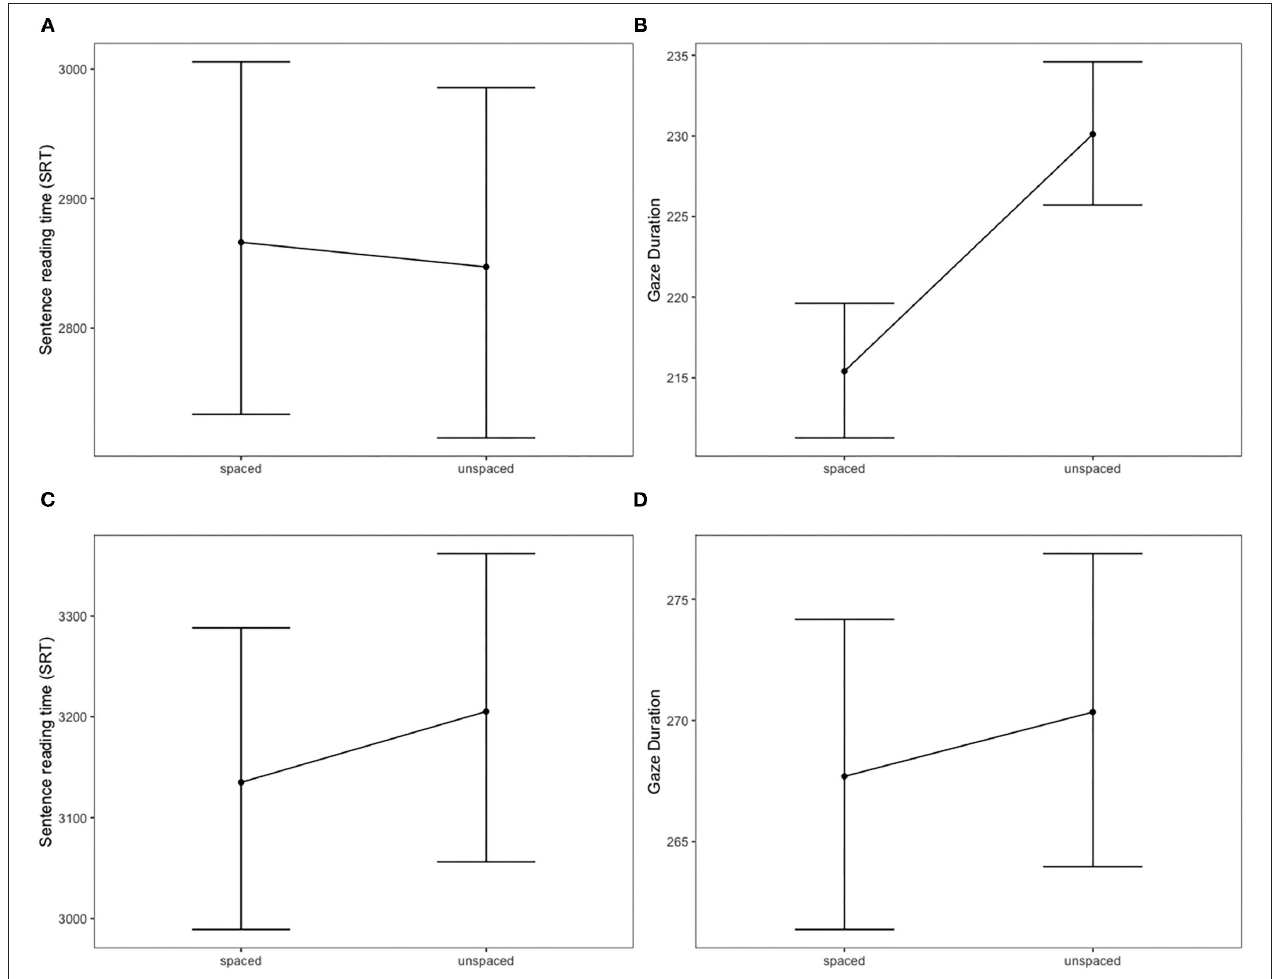
FIGURE 1 | Top left (A) Partial effects of spacing (heavily spaced vs. unspaced) on sentence reading times, Experiment 1. Top right (B) Partial effects of spacing (heavily spaced vs. unspaced) on gaze duration, Experiment 1. Bottom left (C) Partial effects of spacing (lightly spaced vs. unspaced) on sentence reading times, Experiment 2. Bottom right (D) Partial effects of spacing (lightly spaced vs. unspaced) on gaze duration, Experiment 2. Error bars stand for 95% confidence